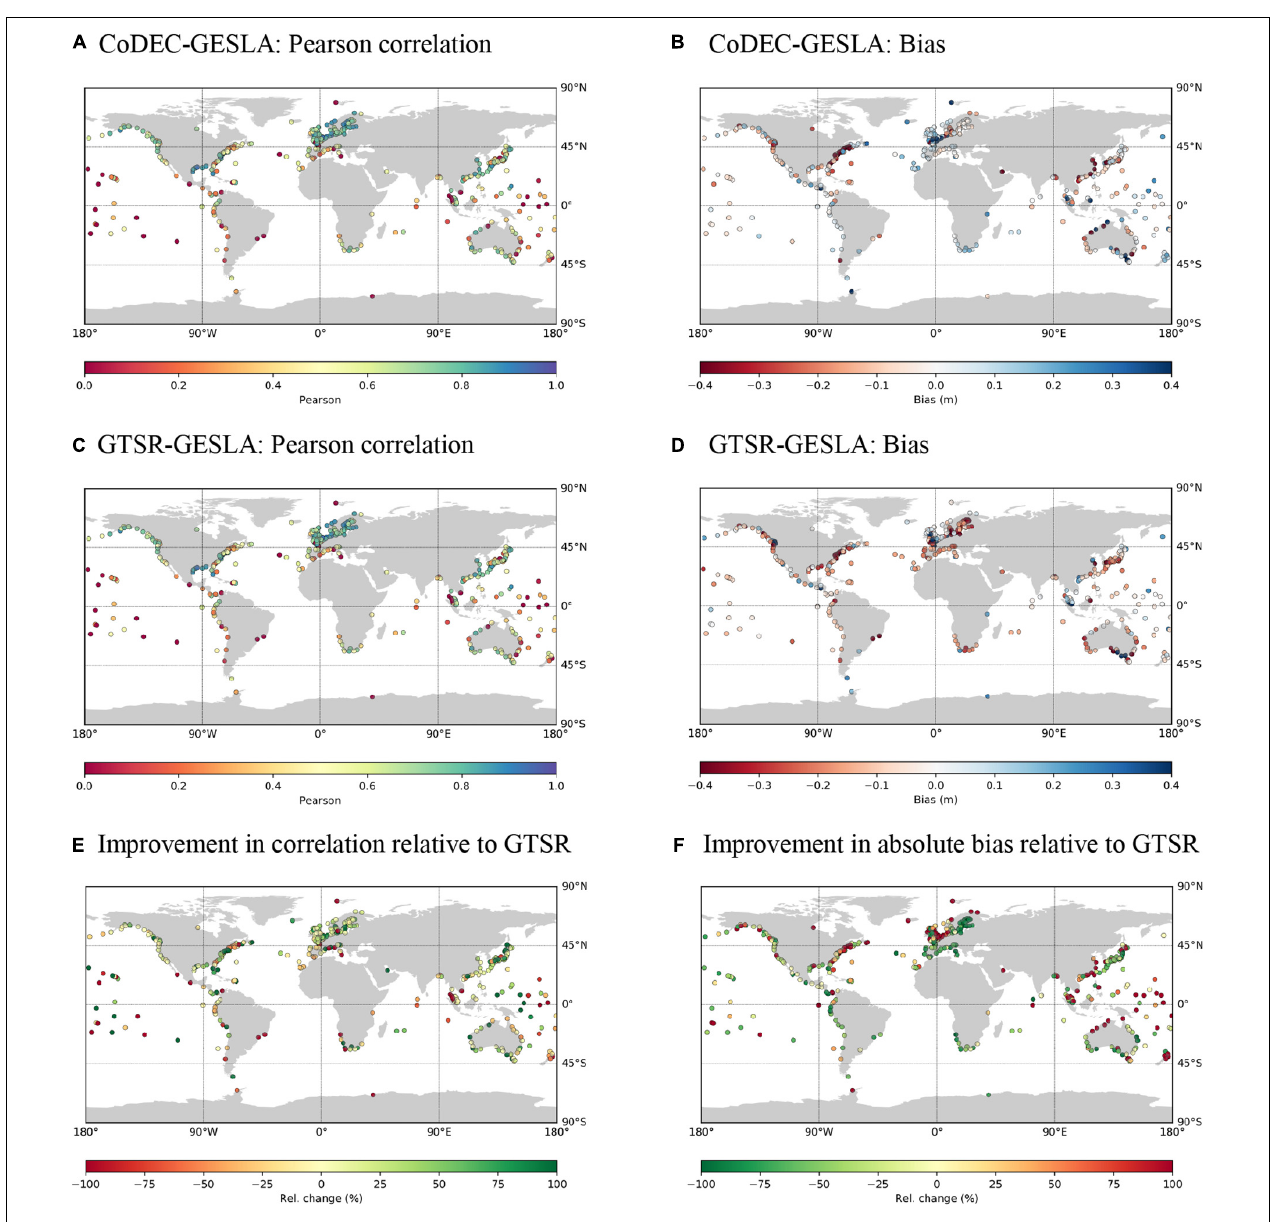
FIGURE 2 | Model performance of the modeled annual maxima evaluated against observed annual maxima from the GESLA dataset. We show Pearson’s correlation coefficient of the annual maxima for (A) CoDEC-ERA5 and (C) GTSR, as well as (E) the relative changes in correlation coefficients between the two datasets. In addition, we show the mean bias over the annual maxima for (B) CoDEC-ERA5 and (D) GTSR, as well as (F) the relative changes in the mean bias between the two datasets.